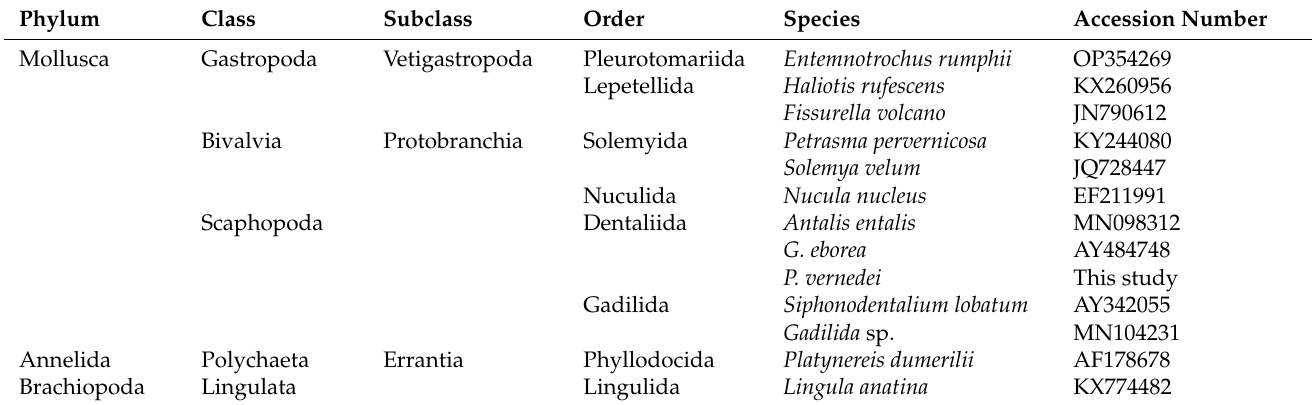
Table 1. Species selected for phylogenetic analysis and gene order